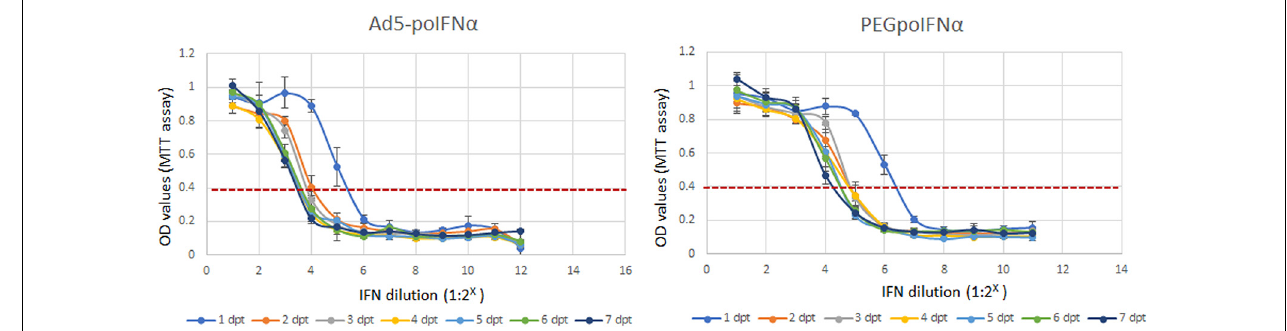
FIGURE 1 | In vitro antiviral activity of PEGpoIFN α . Porcine IB-RS2 cells were treated with two-fold serial dilutions of Ad5-poIFN α expressed poIFN α or PEGpoIFN α (starting material 2 - 1 to 2 - 12 dilutions or ∼ 10 µ g/ml, respectively), and incubated for up to 7 days post-treatment (dpt). At 1 day intervals, supernatants were collected from individual plates and stored at –70 ◦ C. Fresh IB-RS2 cells were treated with the stored supernatants samples containing Ad5-poIFN α expressed poIFN α or PEGpoIFN α . Twenty-four hours post-treatment, IFN containing supernatants were removed and cells were infected with FMDV at MOI-0.1. Cell viability after challenge was measured by MTT assay, 72 h post-infection. OD values of one represent 100% viability, or absence of cytotoxicity. OD values of 0.4 represent maximum cytotoxicity. Results represent the mean of four independent experiments ± SD.